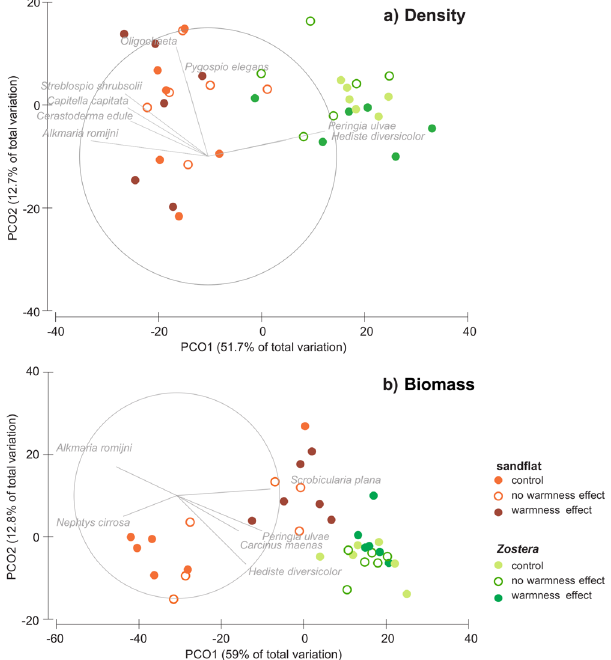
Figure 2. PCO ordination for macrobenthic community density and biomass for each area and treatment. The length and direction of each vector indicates the strength and sign of the relationship between species abundance or biomass and PCO axes, based on a Spearman correlation (only vector with length > 0.5 were